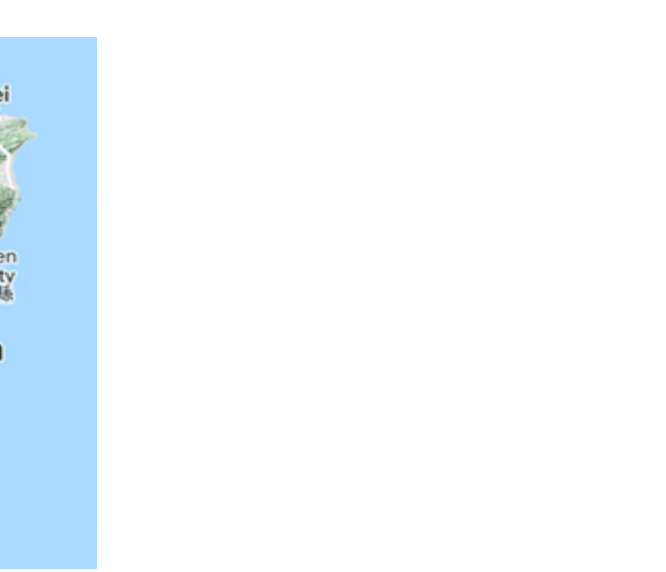
( b ) Figure 8. The simulated environment. ( a ) The distribution of residents per square kilometer by village; ( b ) the distribution of the targeted points for the simulation. 5.2. Demonstration Figure 9 provides the corresponding polygons of City 1, City 2, and City 3 with 2054, 6080, and 7946 vertices. By applying the CoordRecongnit algorithm, the corresponding numbers of inner points could be calculated, which were 89,209, 156,928, and 146,626. Figures 7 and 10a,b, respectively, provide the distributions of the 10,000 random targets in City 1, City 2, and City 3. In addition, some information, such as the area and popula- tion of the cities, can be merged for various applications. These cities cover about 272, 2215, and 2595 km 2 and contain populations of about 2.65 million, 2.82 million, and 2.77 million people, respectively. In addition to the numbers of targets in specific areas, the average number per square kilometer or the average number of targets per million peo- ple in each area may be more helpful information. Table 2 provides the densities with geographical information. For the area density per square kilometer and the population density per million people, City 1 has 328 and 33,644, respectively, City 2 has 71 and